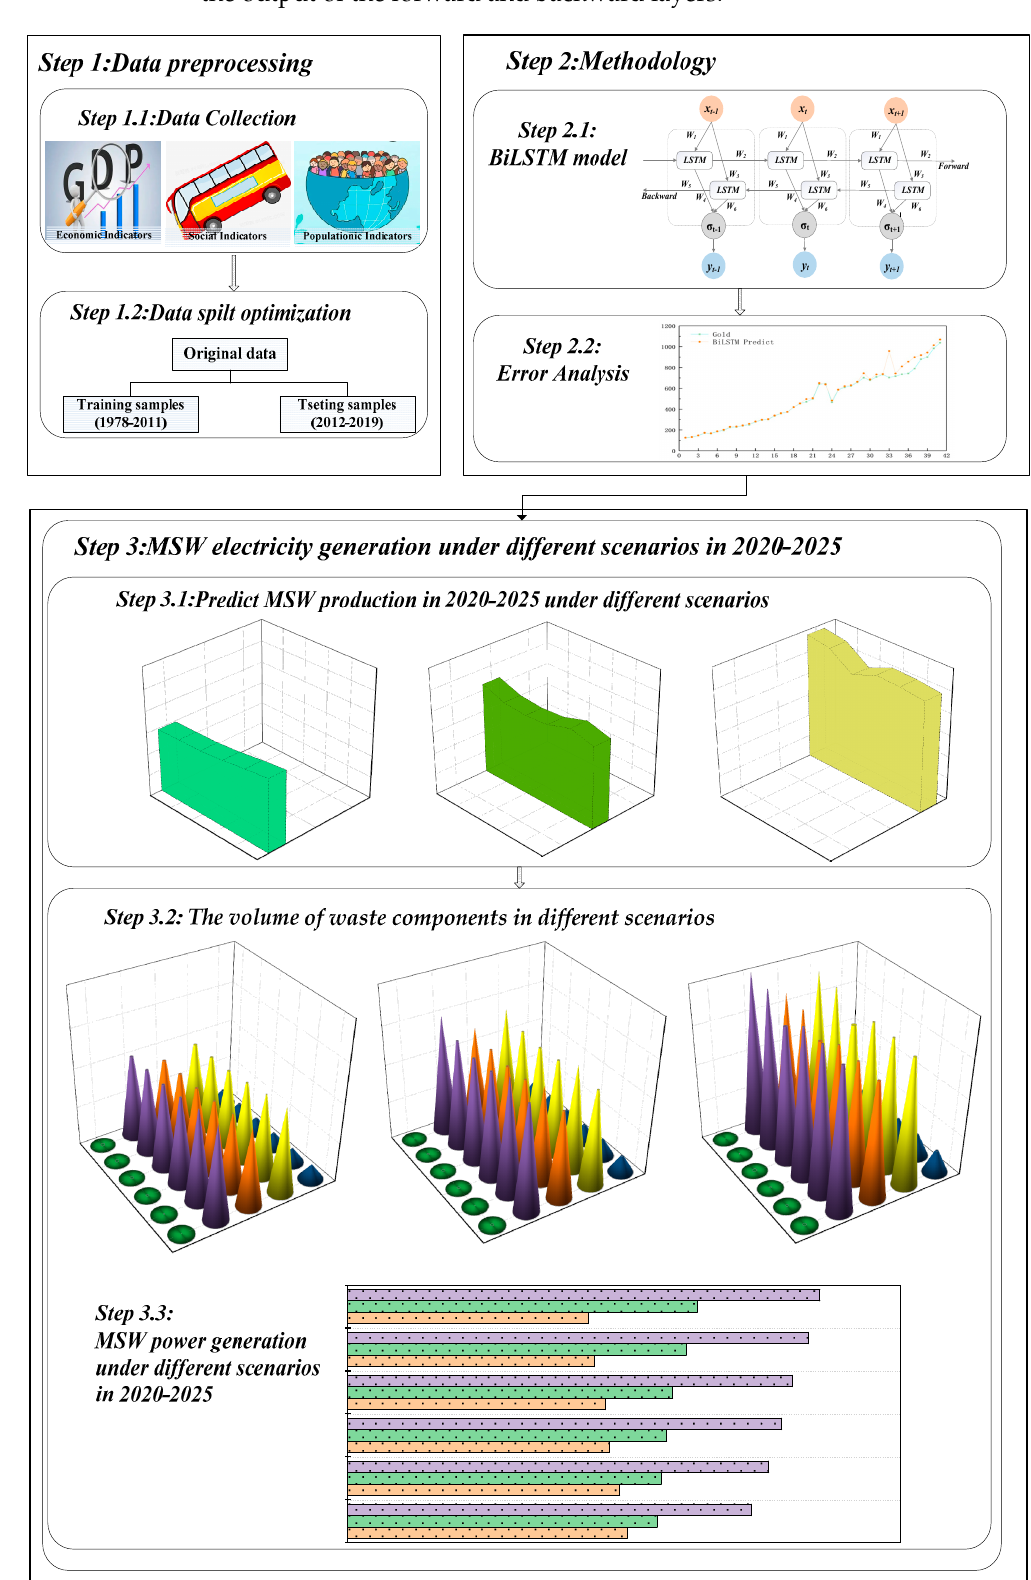
Figure 1. Logical structure diagram of this research.